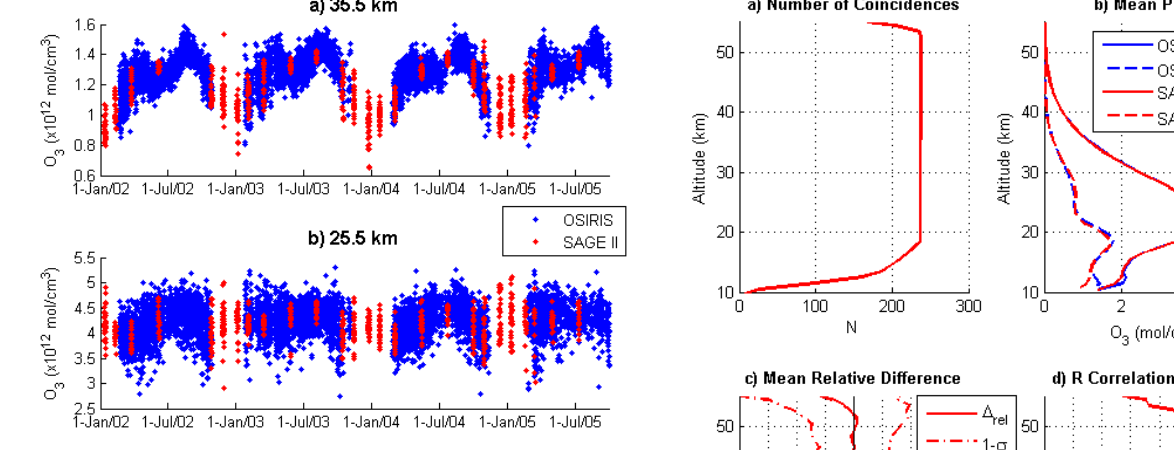
Fig. 2. Time series of OSIRIS (blue) and SAGE II (red) ozone mea- surements for 40–45 ◦ N at (a) 35.5km and (b) 25.5km. Figure 2: Time series of OSIRIS (blue) and SAGE II (red) ozone measurements for 40-45°N 2 at (a) 35.5 km and (b) 25.5 km. 3